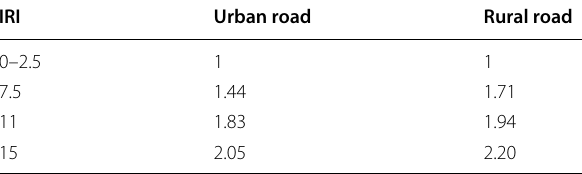
Table 2 Relative time values for roads with different road surface, estimated based on NZ Transport Agency [25]